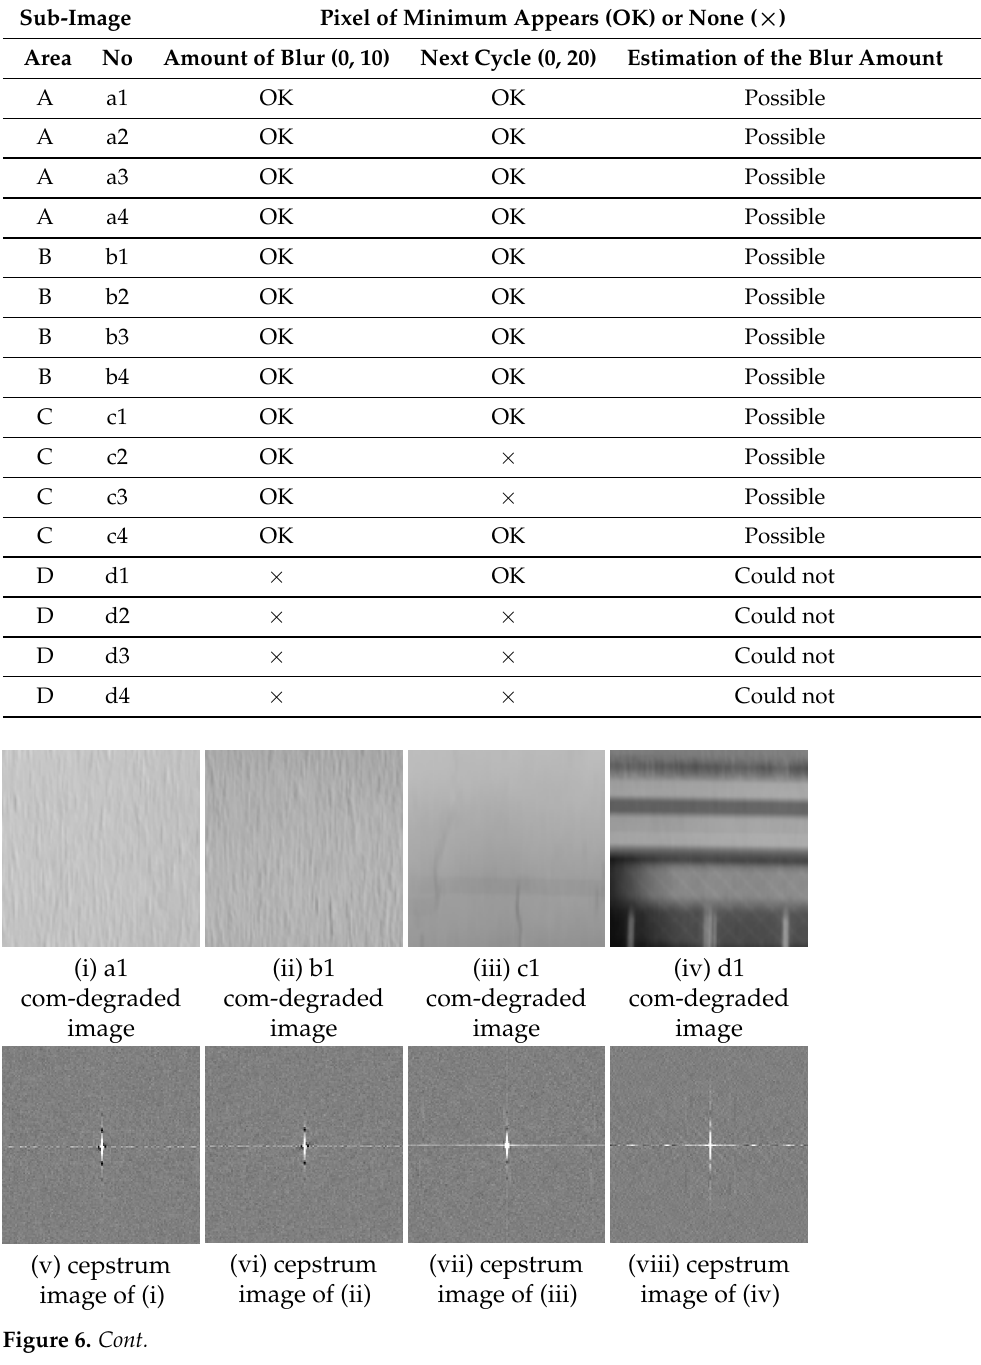
Table 4. The blur amount (10 pixels, 90 degrees).